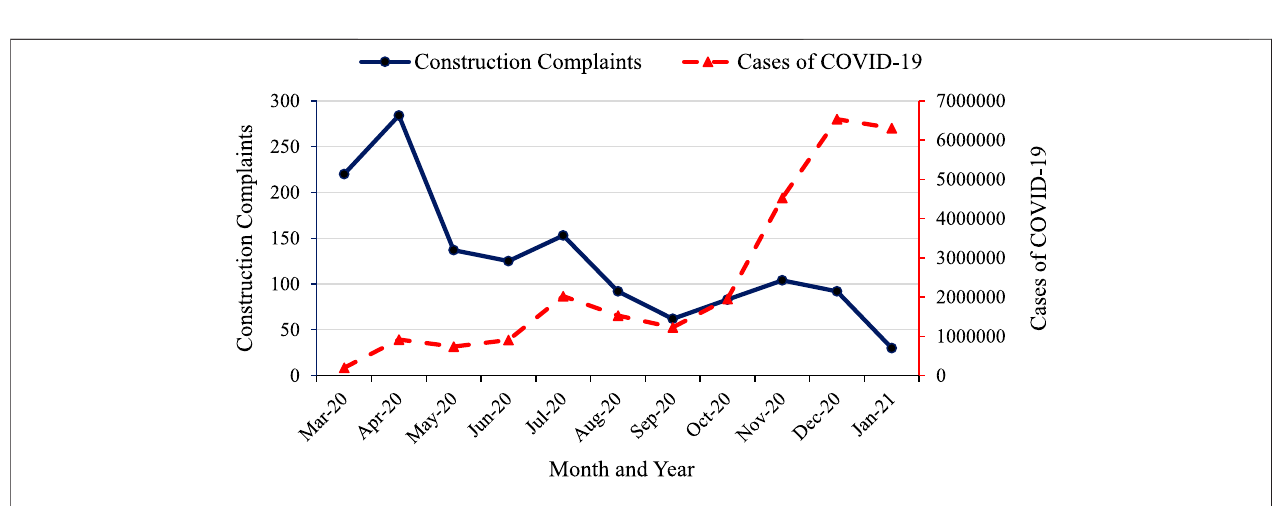
FIGURE 2 | Variation in construction-related complaints and COVID-19 cases with time.